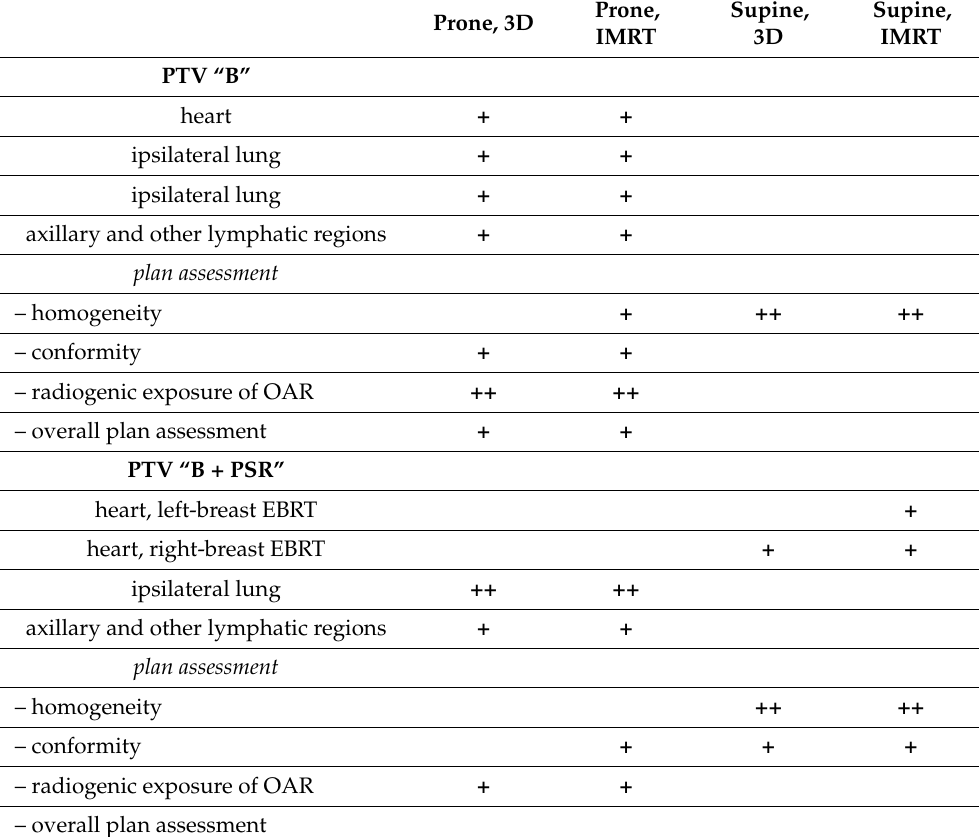
Prone, Supine, Supine, Prone, 3D IMRT 3D IMRT